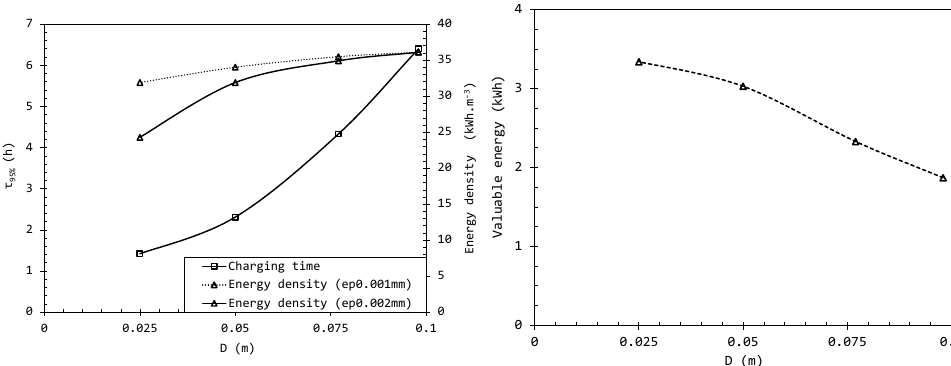
Figure 13. Influence of the nodules’ diameters on the charging time τ 95% (left) and valuable discharge energy above 45 °C (right).